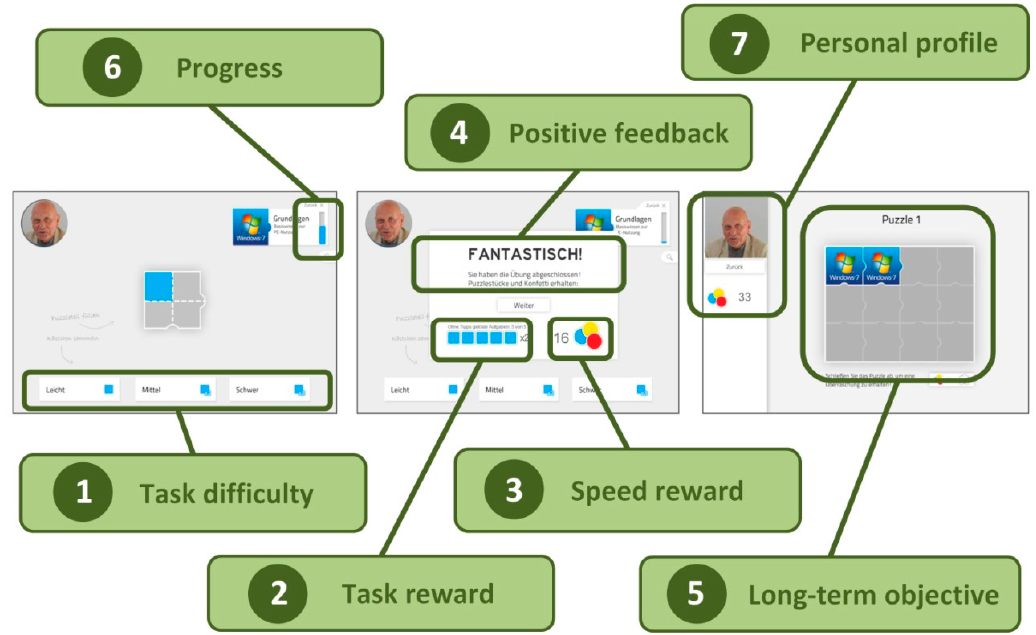
Figure 2. Screenshots and gamification elements of the gamified PC trainer application. Screenshots are showing the task selection window (left), the feedback pop-up after solving a set of five tasks displaying “Congratulation” (middle), and the personal profile depicting the puzzle (right).